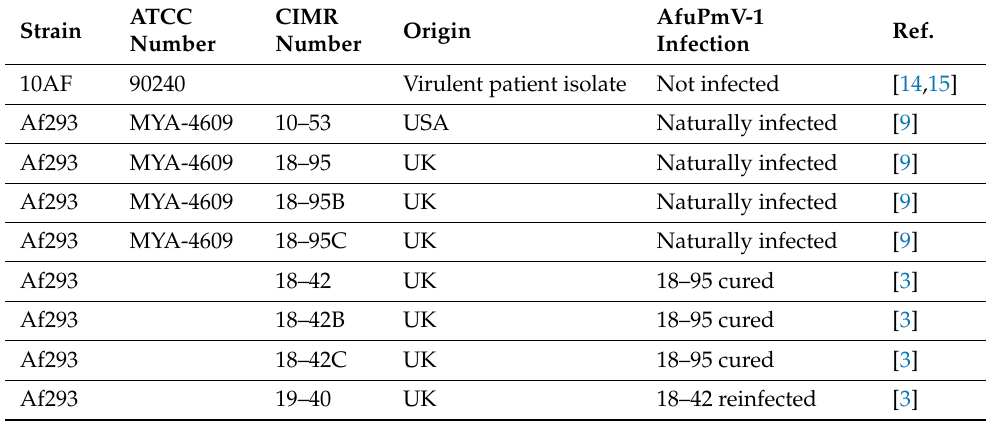
Table 1. A. fumigatus strains used in this